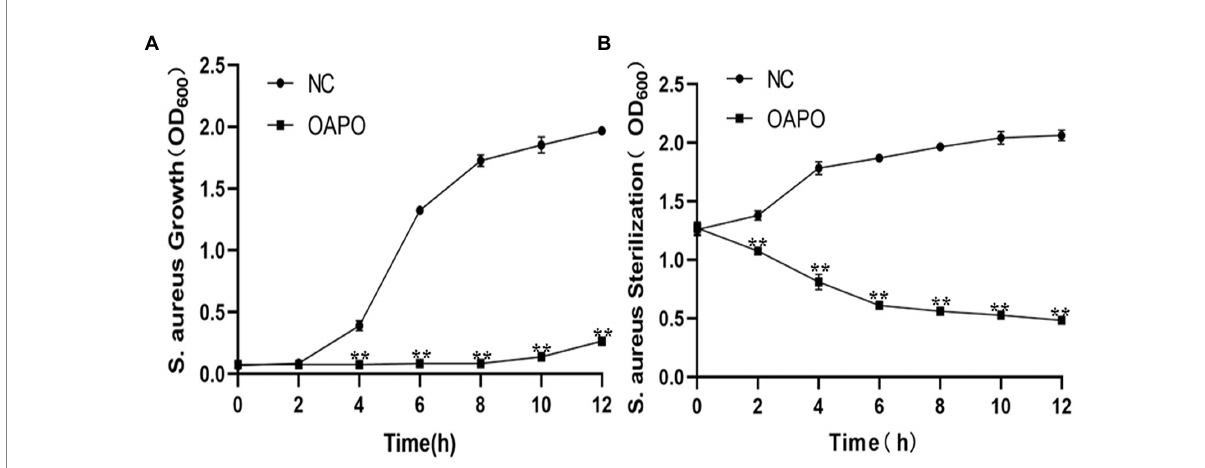
FIGURE 2 Organic acid of Portulaca oleracea L. (OAPO) killing of Staphylococcus aureus visualized by the growth (A) and bacteriostasis curves (B) . The OD 600nm of S. aureus culture suspension at 0, 2, 4, 6, 8, 10, and 12 h post-coculture with or without 1-fold minimum inhibitory concentration (MIC) of OAPO. NC: negative control, S. aureus culture without OAPO; OAPO: S. aureus culture with 1-fold MIC of OAPO. **indicates p < 0.01 when compared with the negative control group (NC, untreated with